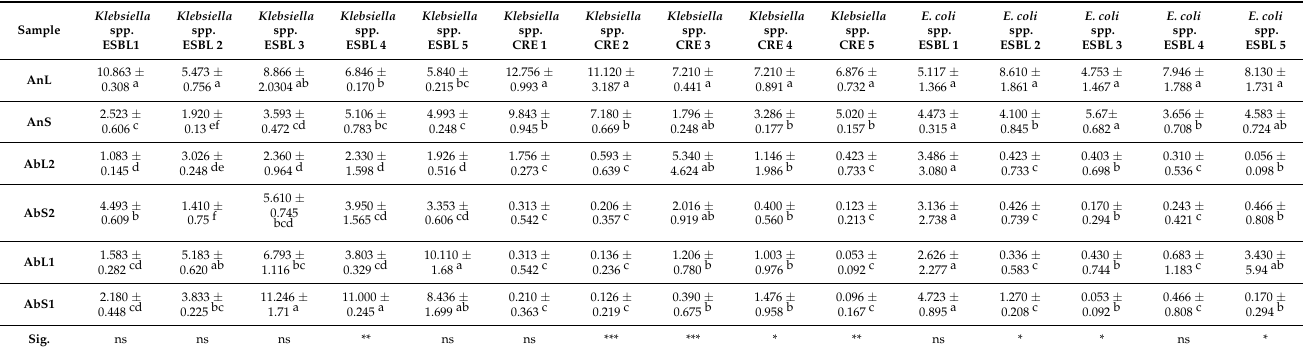
Table 5. Inhibition zones induced by wormwood against bacterial strains